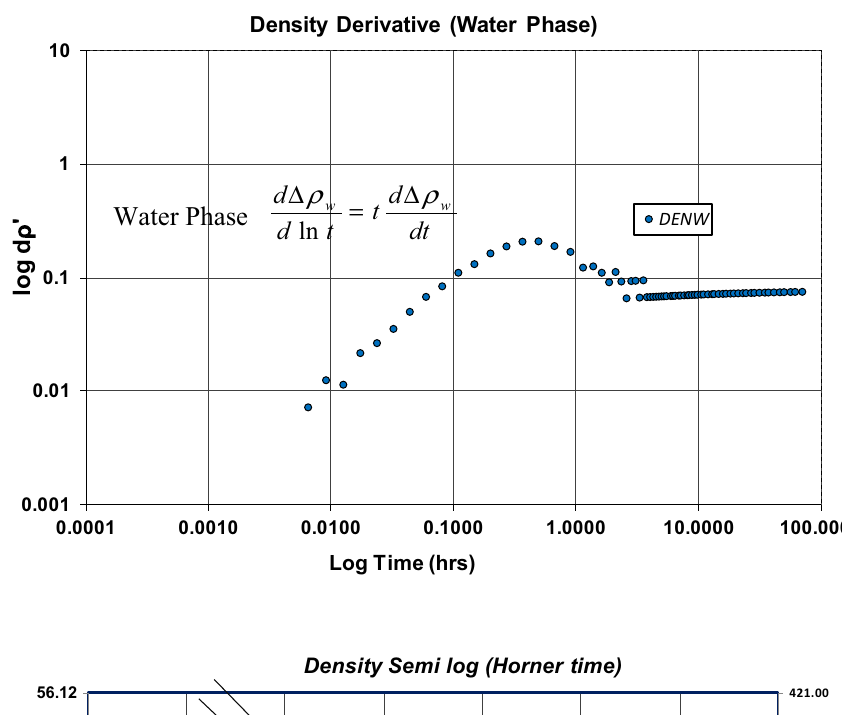
Fig. 15 Specialised semi-log oil and gas phase densities versus Horner